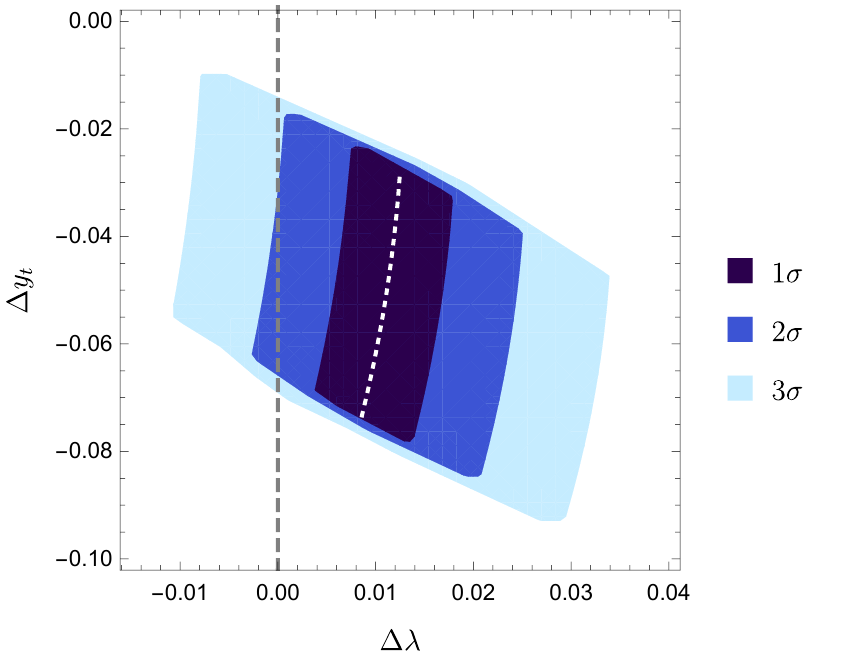
Figure 2 . Values of the jumps ∆ λ and ∆ y t that lead to a potential with a feature but with the CMB observables within the 2 σ limits (2.17). The dashed white line corresponds to the central EW parameter values (2.12). In the coloured regions the SM parameters vary within their 1 σ , 2 σ , and 3 σ